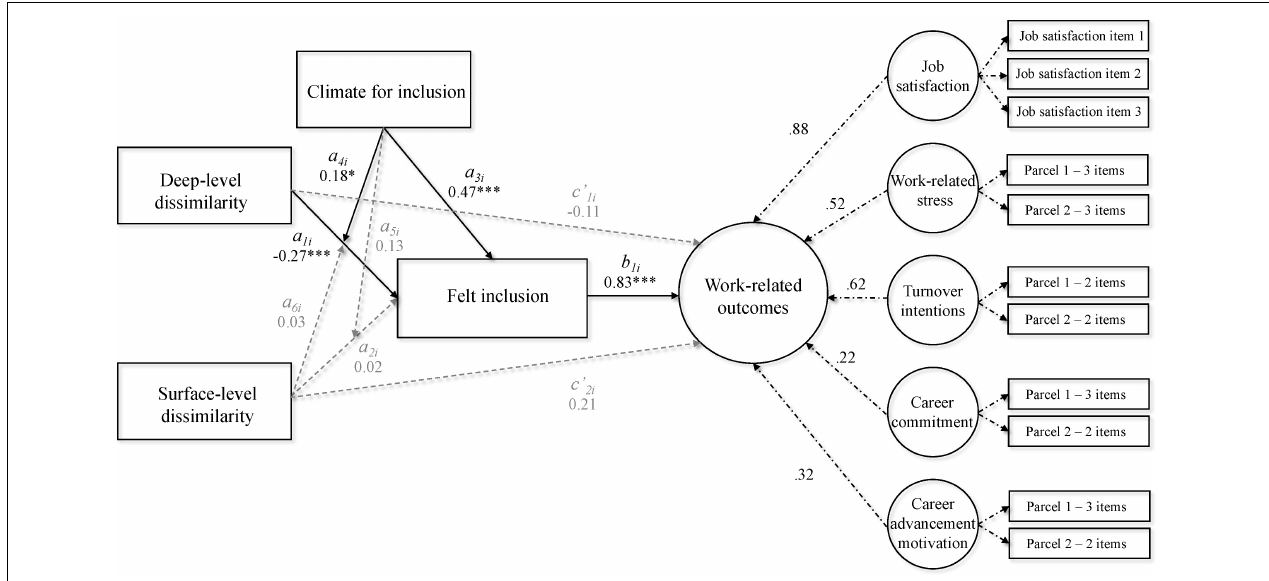
FIGURE 1 | Conceptual overview of the structural equation model with standardized factor loadings and unstandardized parameter estimates. ∗∗∗ p < 0.001, ∗ p < 0.05.